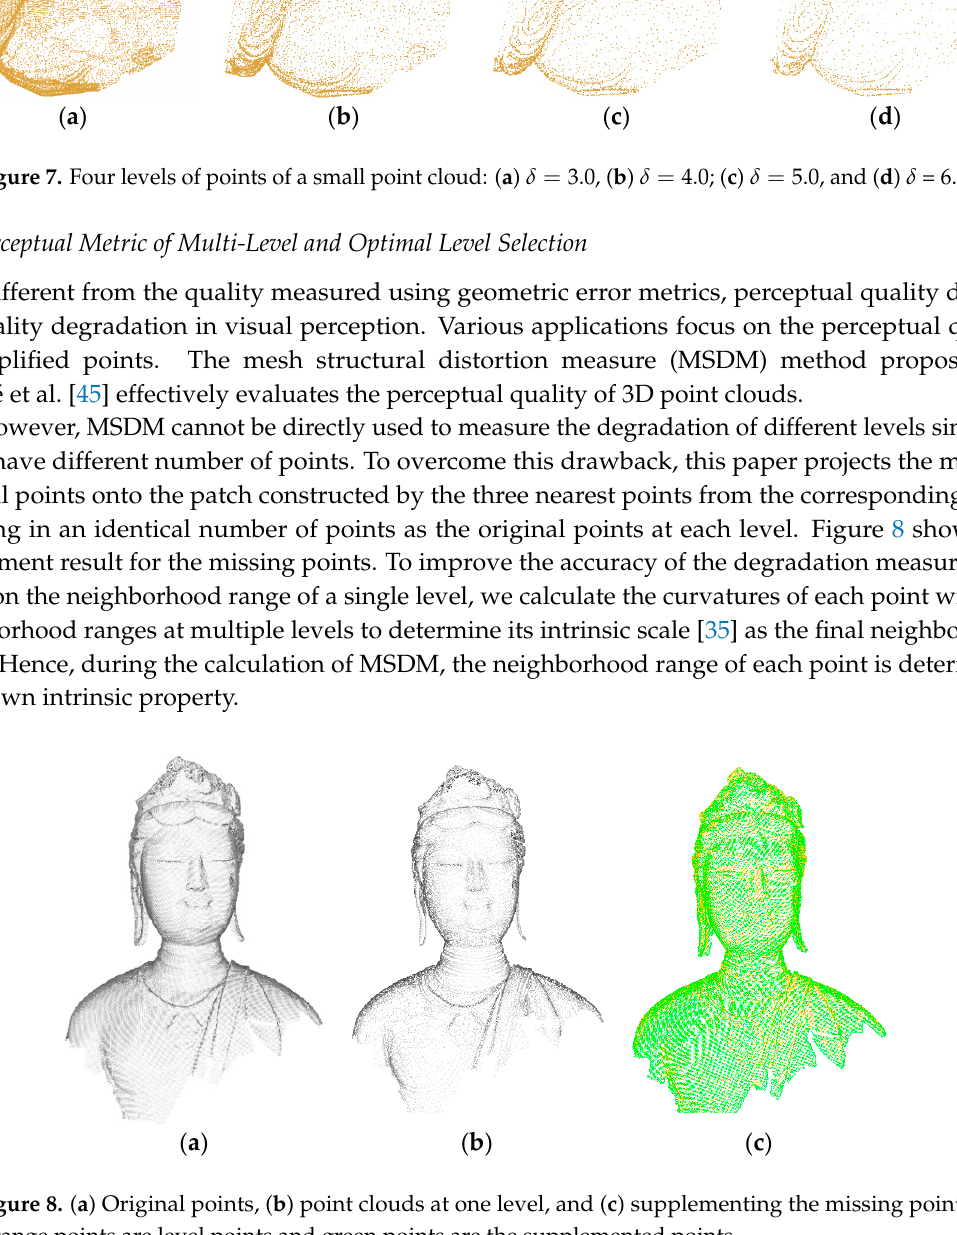
Figure 6. Significant points detected of four levels.